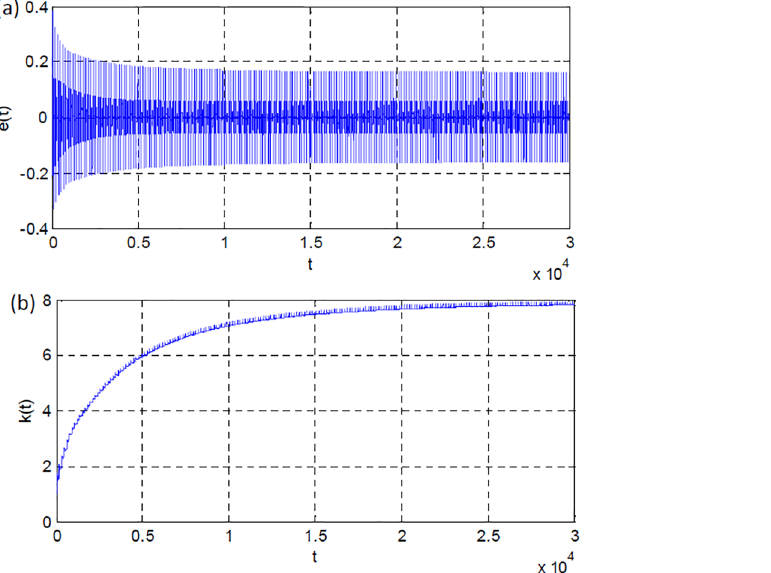
Fig 4. (a) Model error, (b) adaptationgain from the first